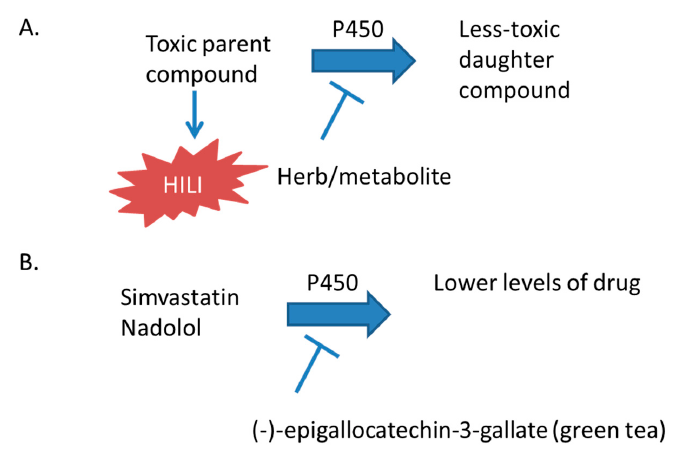
Figure 1. The effect of P450 inhibitors on drug toxicity. The parent compound can be the herbal supplement itself or a co-administered Food and Drug Administration (FDA)-approved drug. ( A ) Schematic of the general mechanism; ( B ) a specific example discussed in the text [5]. The expression of CYP450 enzymes is induced by nuclear receptors that respond to xenobiotics. receptor (PXR, also known as NR1I2, SXR, or PAR) and constitutive androstane receptor (CAR;